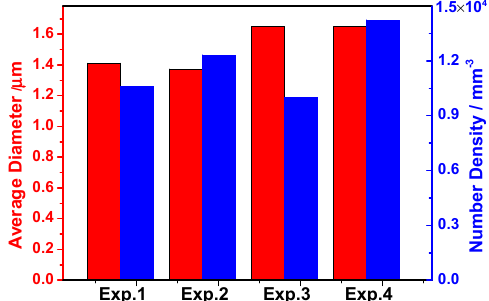
Figure 6. Three-dimensional average diameter and number density of Type-1 inclusions.